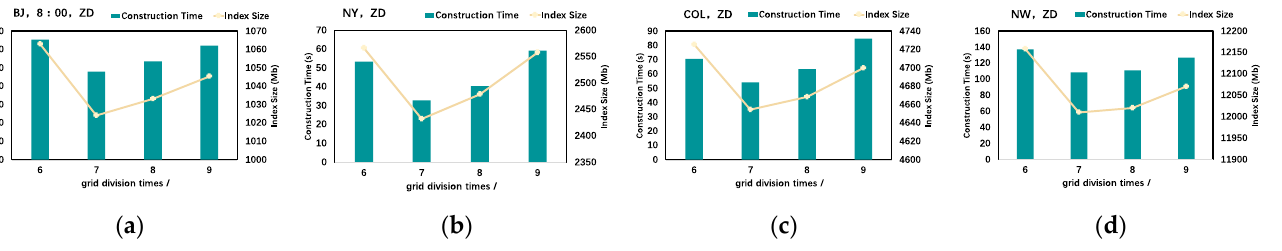
Figure 9. Construction time and space costs overhead of DVTG-Index w.r.t. l. ( a ) Construction time and space costs on BJ; ( b ) Construction time and space costs on NY; ( c ) Construction time and space costs on COL; ( d ) Construction time and space costs on NW.